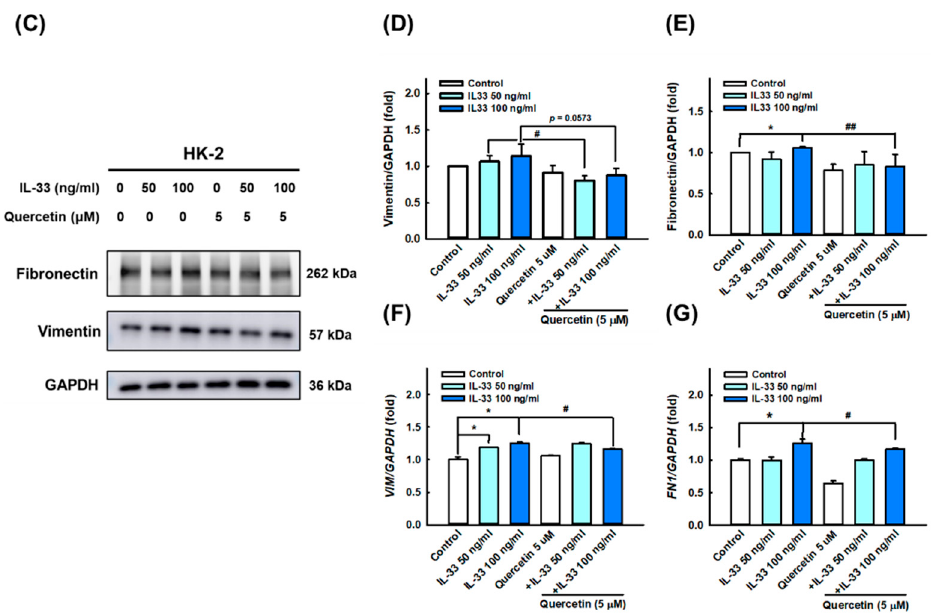
Figure 2. Quercetin reduced fibrosis-related proteins expression in human renal tubular epithelial cell line. HK-2 cells were co-cultured with 5 μ M quercetin and 50 ng/mL or 100 ng/mL recombinant human IL-33 for 48 h. ( A – B ) Representative photomicrographs show the immunofluorescence staining for vimentin and fibronectin among different groups. Magnification, 400 × . ( C – E ) Immunoblots and quantitative histograms showing the results of Western blotting analysis for the expression of vimentin and fibronectin protein. ( F – G ) Quantitative histograms showing the results of qPCR analysis for VIM and FN1 mRNA level. Data are expressed as mean ± SD ( n = 3). * p < 0.05 versus control group; # p < 0.05 versus corresponding IL-33-stimulated group; ## p < 0.001 versus corresponding IL-33-stimulated group.